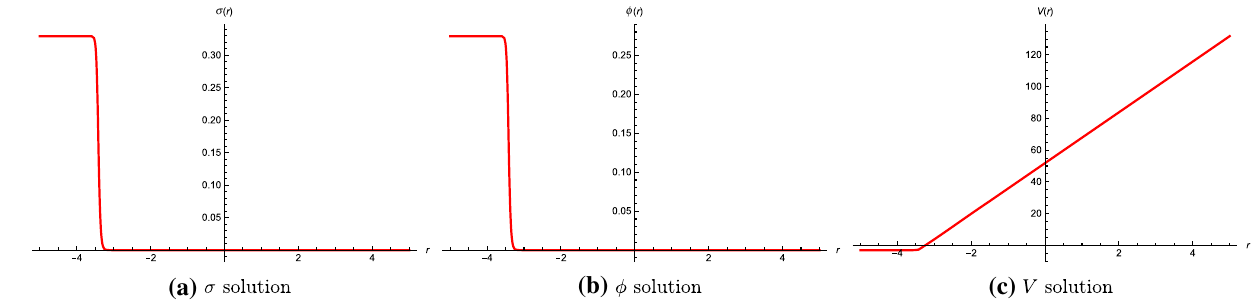
Fig. 16 An RG flow from SO ( 4 ) N = ( 1 , 0 ) SCFT in six dimensions to two-dimensional N = ( 1 , 0 ) SCFT with SO ( 3 ) diag symmetry dual to